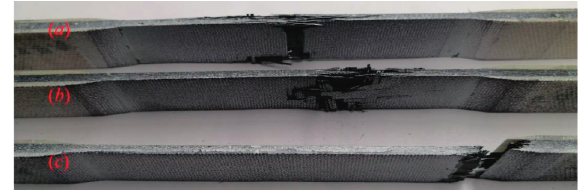
Figure 9: Failure sites of scratched samples.